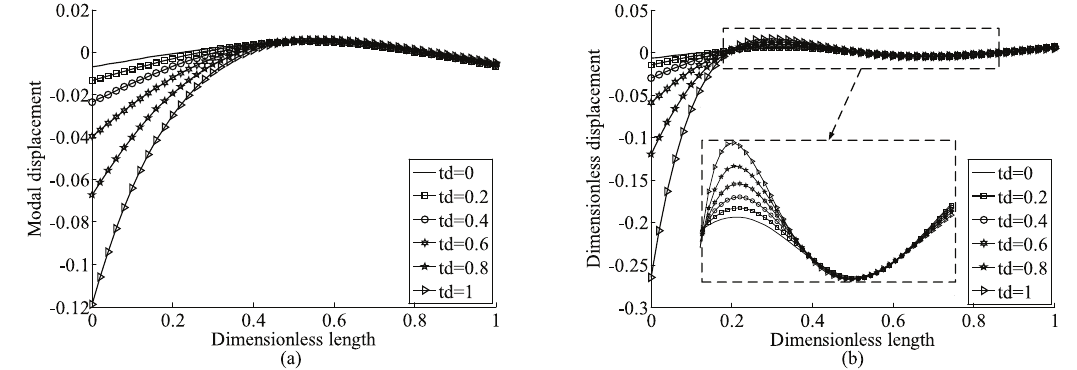
Fig. 9. The variation of first two modal shapes with tapered orders of beams under free-free boundary condition: (a) the first modal shapes, (b) the second modal shapes.